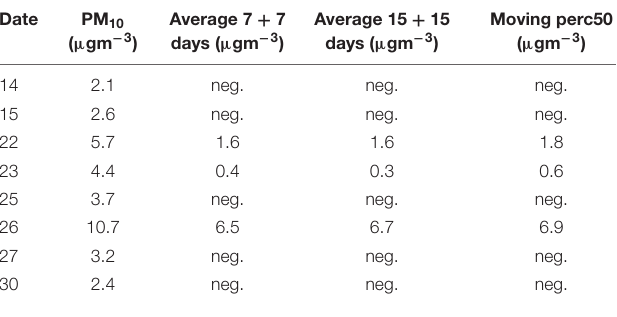
TABLE 5 | Dust load estimates for April